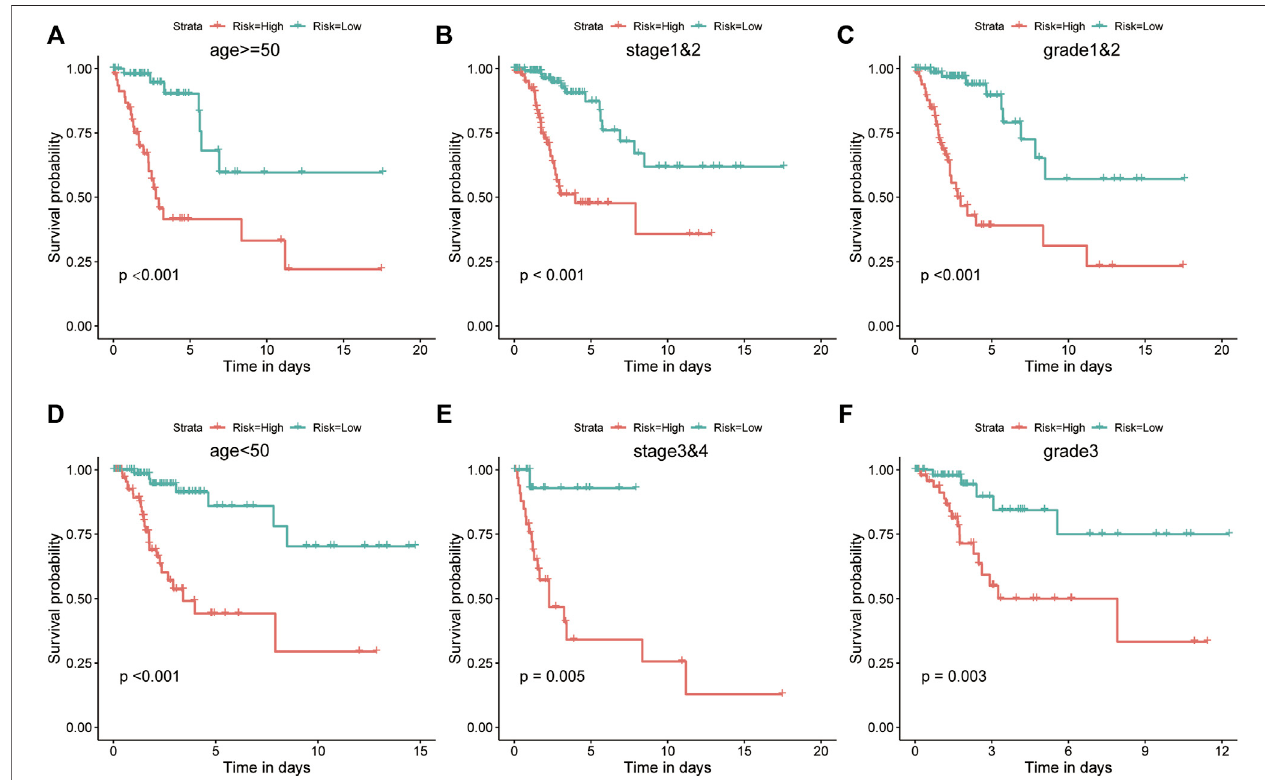
FIGURE 6 | The risk score was a better predictor of OS across multiple subgroups of the training set. (A – F) KM analysis of OS was conducted for various clinicopathological subgroups, including age, stage, and grade. Patients with high risk scores had a worse